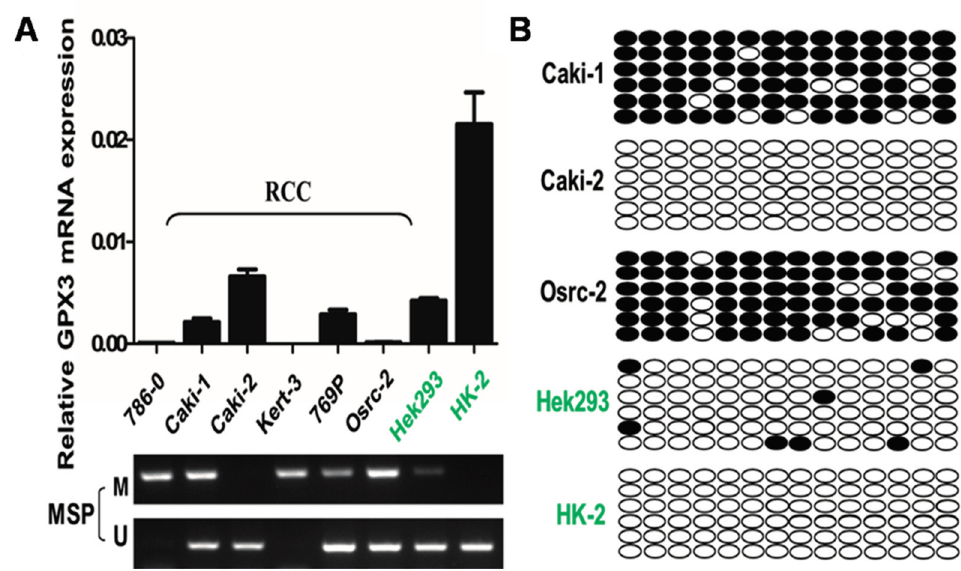
Figure 1. GPX3 downregulation by promoter hypermethylation in ccRCC cell lines. ( A ) Detection of GPX3 mRNA expression and methylation in a panel of ccRCC, Hek293, and HK-2 cell lines by real time RT-PCR and MSP. M , methylated . U , unmethylated; ( B ) Representative methylation analysis of individual CpG sites in the GPX3 promoter by bisulfite genomic sequencing. Each row represents one bacterial clone with one circle symbolizing one CpG site. Filled ovals indicate methylated. Open ovals indicate